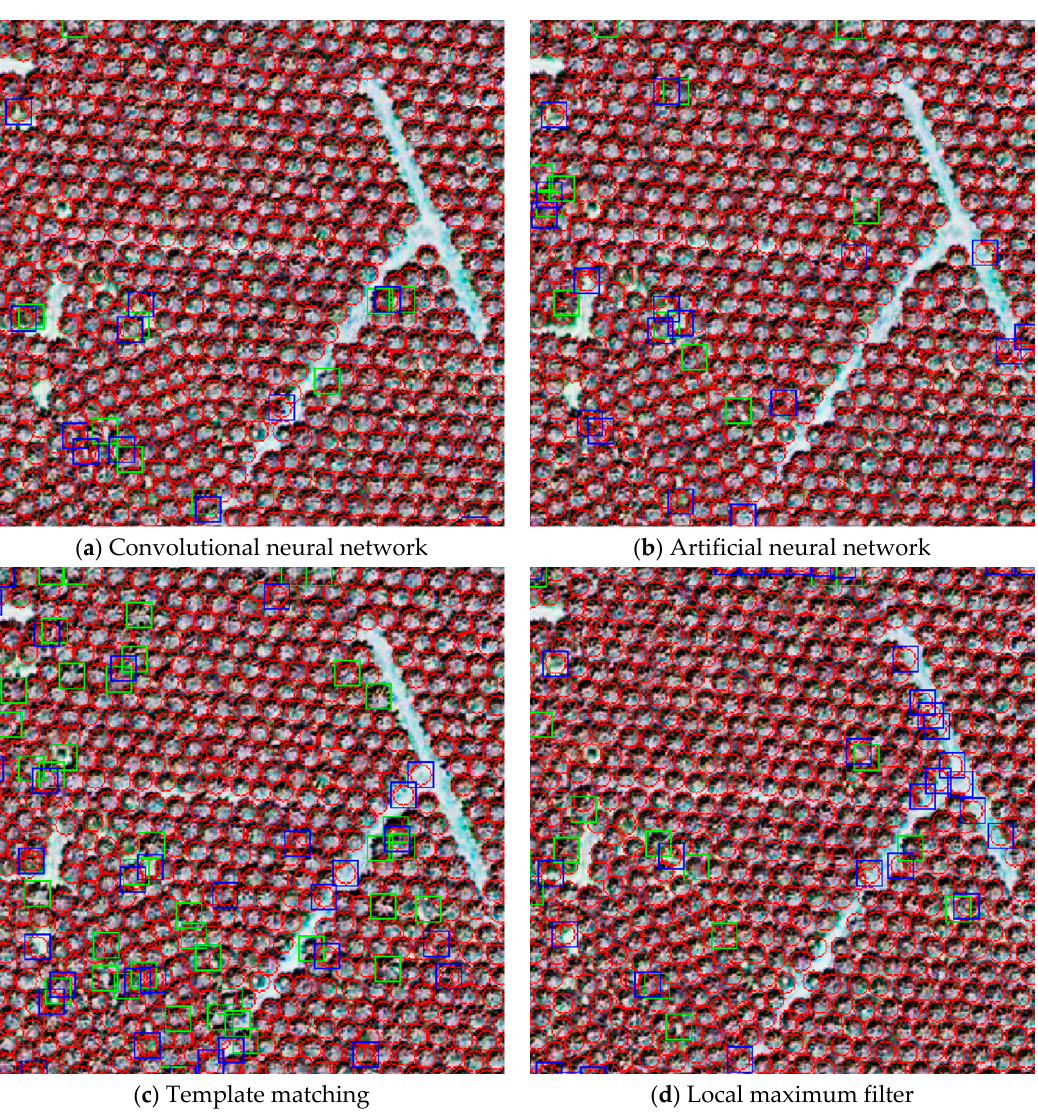
Figure 8. Detection image of each method for region 3 (extracted area).